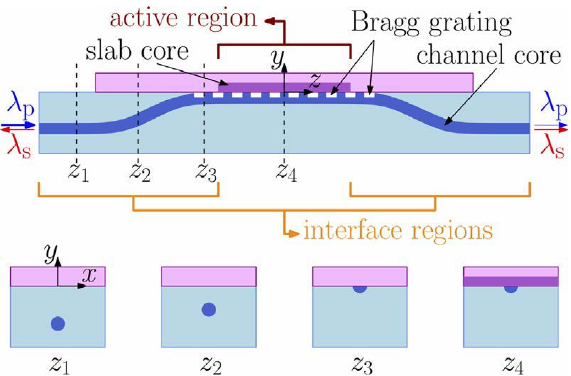
Figure 8. Longitudinal ( top ) and cross ( bottom ) sections of the hybrid DFB laser structure. Repro- duced with permission of Elsevier from